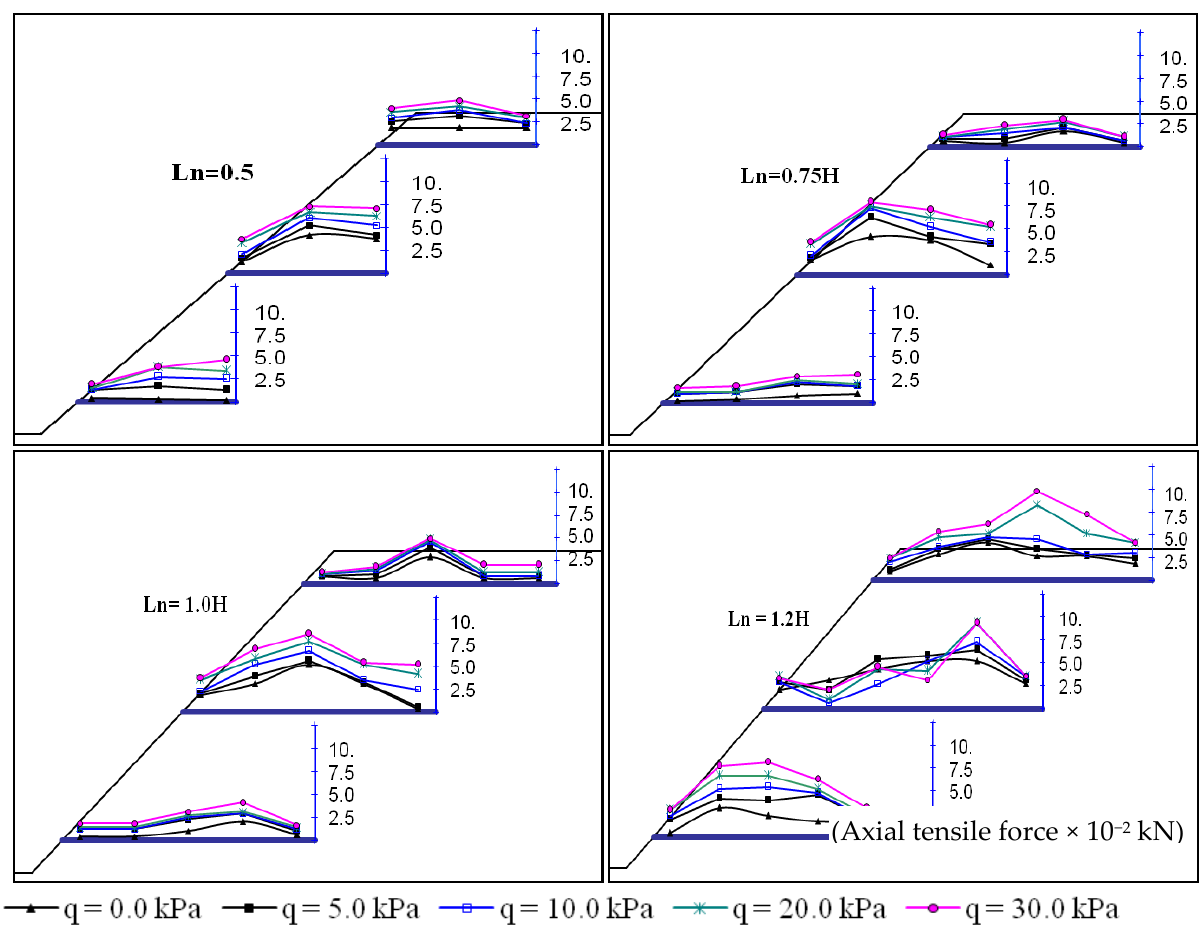
Figure 8. Distribution of the nail force at different levels and nail lengths.